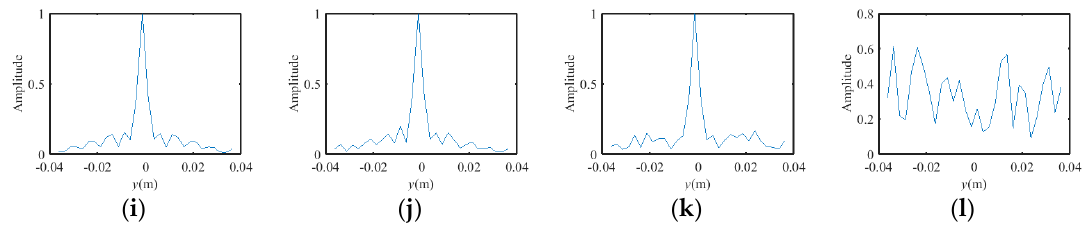
Figure 5. Vertical view of the point spread function (PSF) with different phase-modulation ranges, including, ( a ) no modulation, ( b ) [ − 0.25 π , 0.25 π ], ( c ) [ − 0.5 π , 0.5 π ], ( d ) [ − π , π ], respectively. The x-axis cross-section view of the PSF function (PSF) with different phase-modulation ranges, including, ( e ) no modulation, ( f ) [ − 0.25 π , 0.25 π ], ( g ) [ − 0.5 π , 0.5 π ], ( h ) [ − π , π ], respectively. The y-axis cross-section view of the PSF function (PSF) with different phase-modulation ranges, including, ( i ) no modulation, ( j ) [ − 0.25 π , 0.25 π ], ( k ) [ − 0.5 π , 0.5 π ], ( l ) [ − π , π ], respectively.